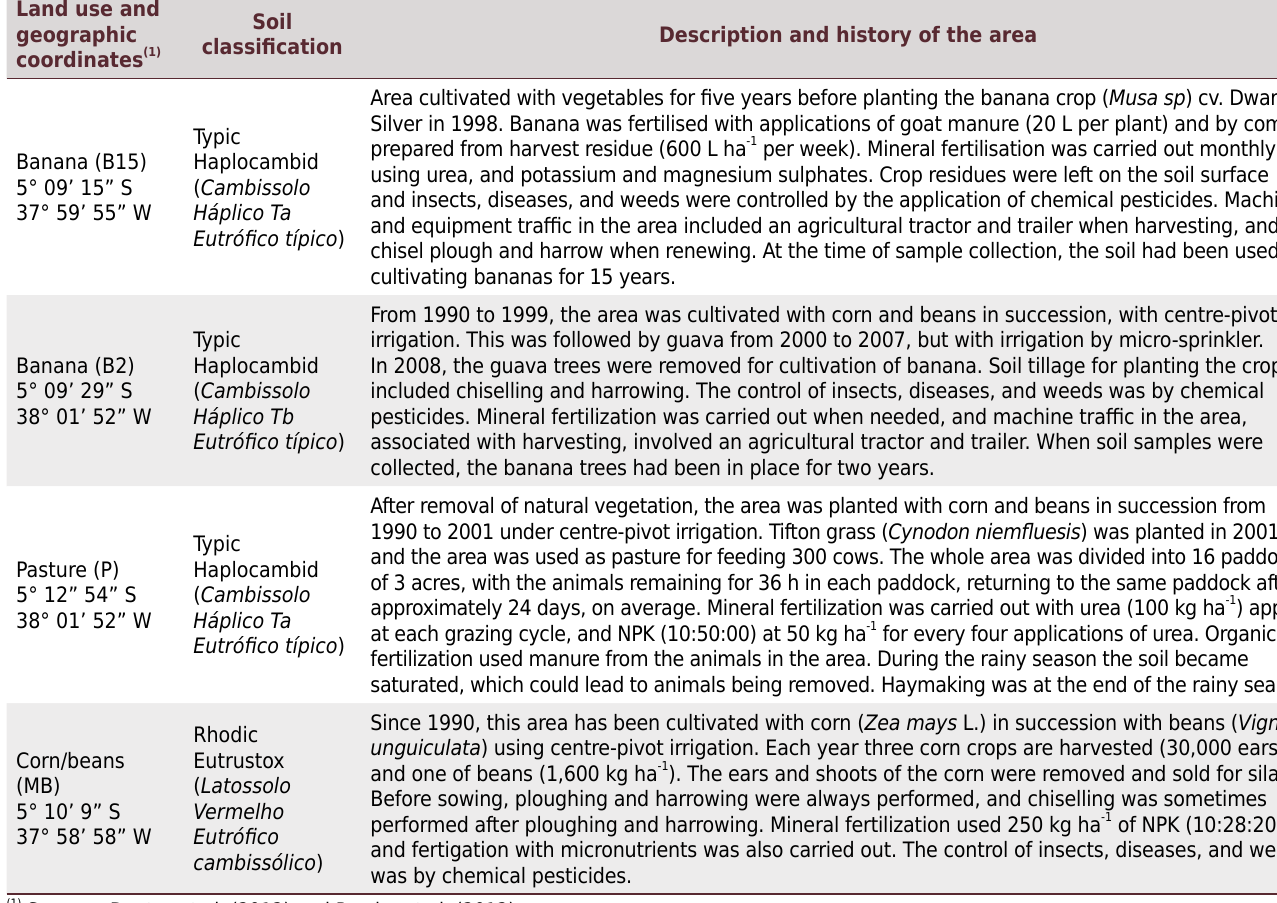
Table 1. Land use, soil classification, and history of the areas under study in the Jaguaribe-Apodi Irrigated Area, Limoeiro do Norte, CE, Brazil Land use and geographic coordinates